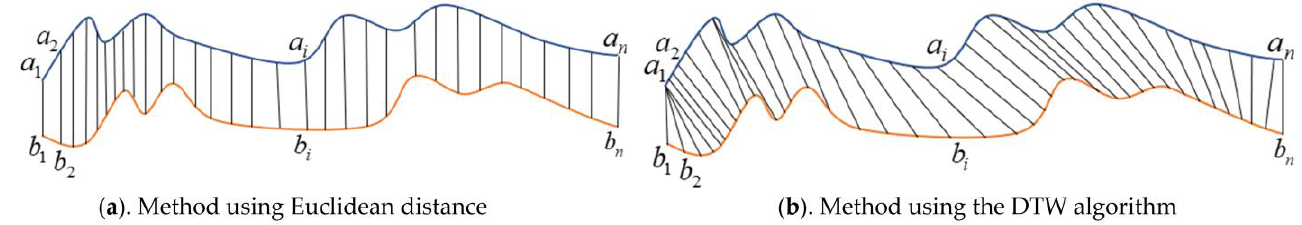
Figure 6. Examples of scenarios where data needs to be recorded. Figure 6. The differences between two methods in distance